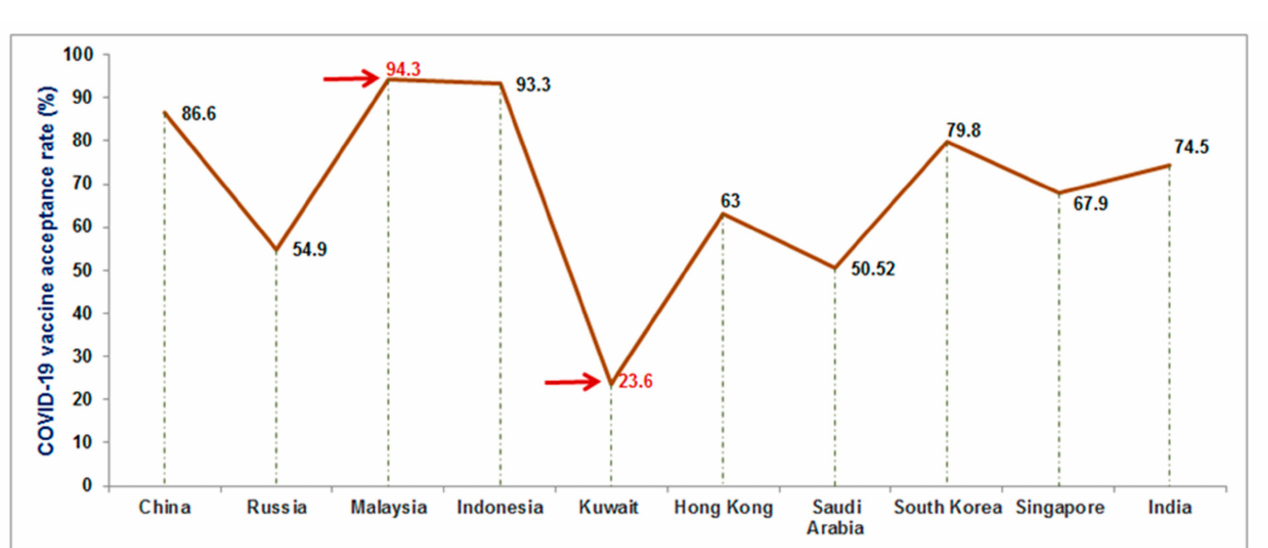
Figure 11. COVID-19 vaccine acceptance rate in some Asian countries. The highest vaccine acceptance rate was noted in Malaysia (94.3%), and the lowest vaccine acceptance rate was reported in Kuwait